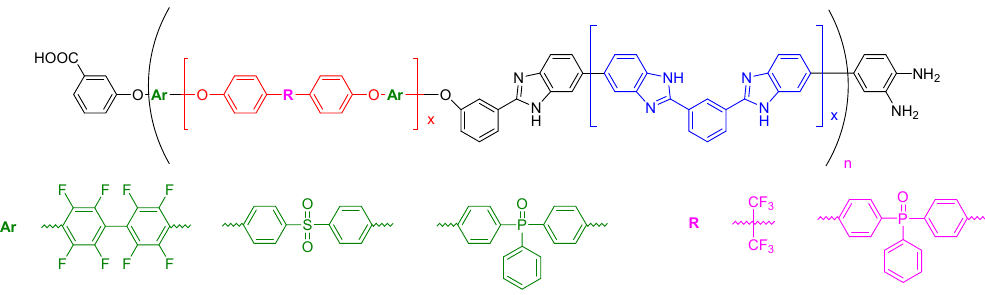
Figure 12. PBI-based block copolymers of phosphophilic PBI and phosphophobic non-PBI segments [115].